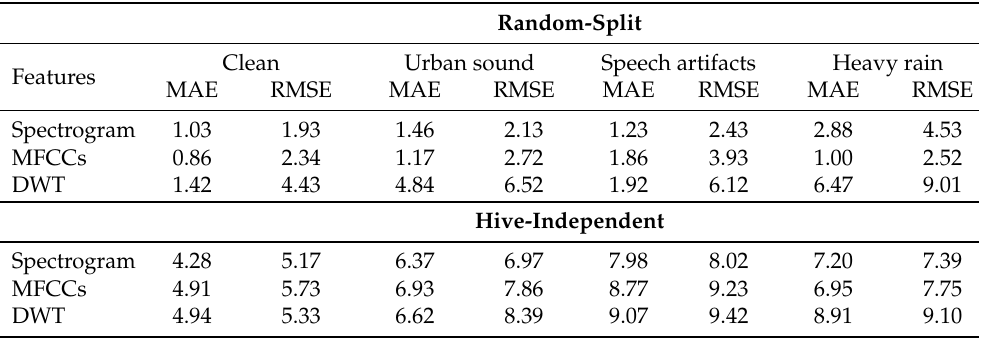
Table 2. Performance comparison (MAE and RMSE) for beehive monitoring systems based on three feature sets under random-split and hive-independent testing scenarios.